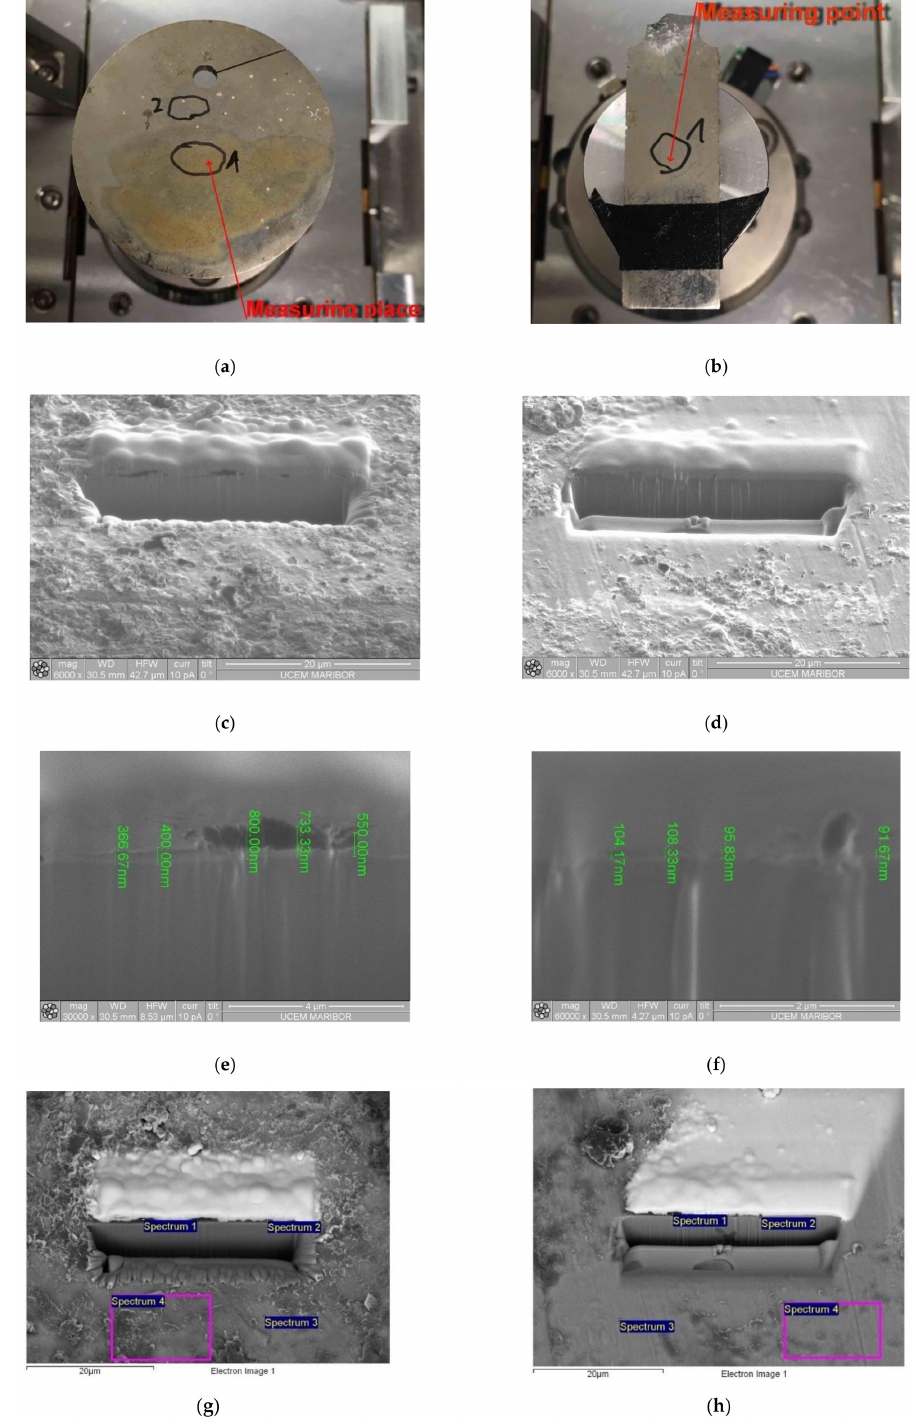
Figure 4. Presentation of corresponding FIB measuring locations: ( a ) NiTi-1, ( b ) NiTi-2; Micro-view of an FIB cut: ( c ) NiTi-1, ( d ) NiTi-2; Corrosion depth values after 1 year in the sea measured by